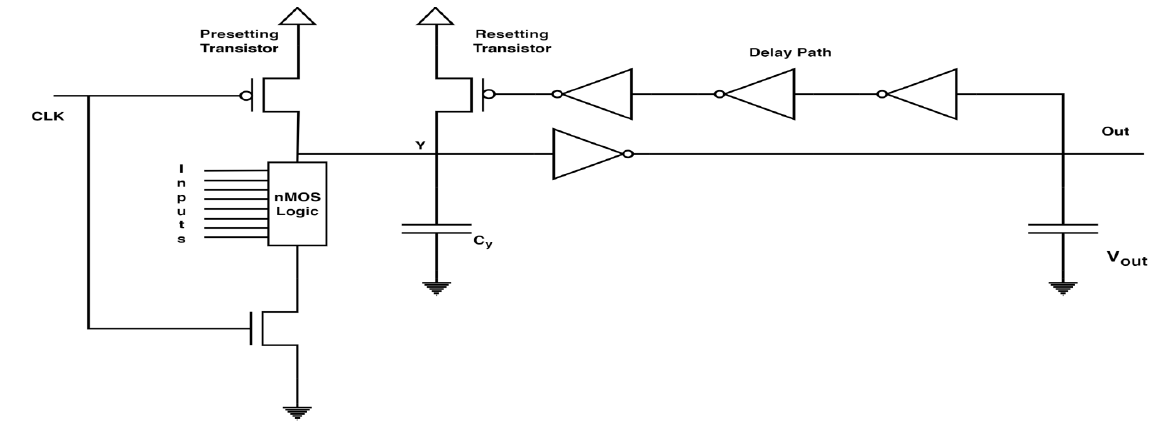
Figure 12. A self-resetting logic circuit (SLRC) with domino-footed logic.